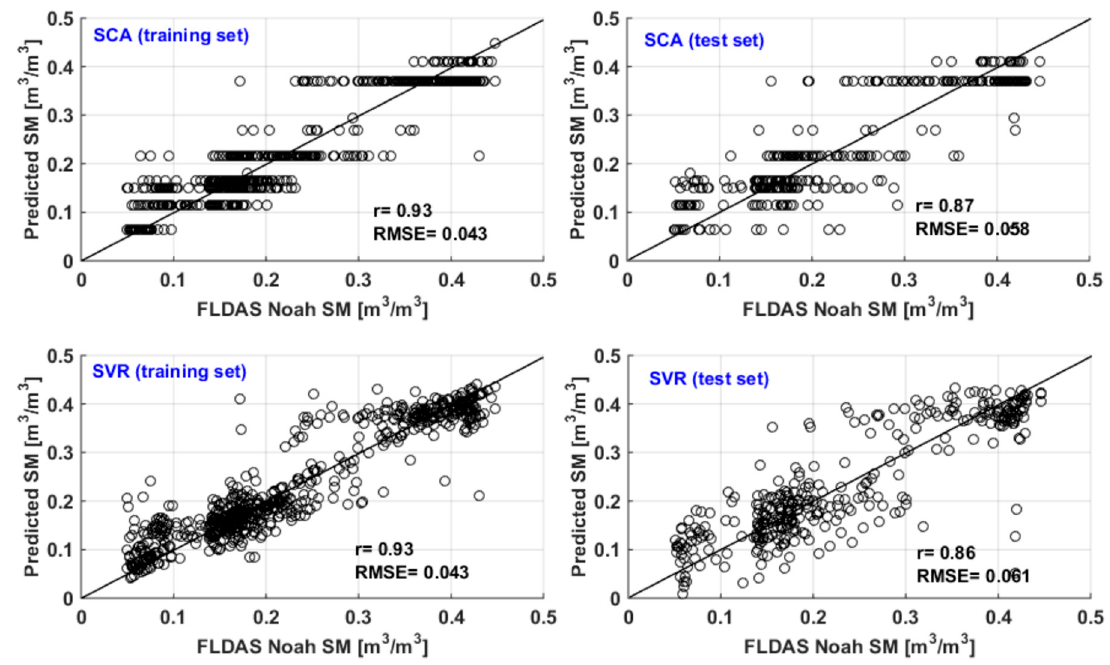
Figure 8. Prediction comparsion of SCA and SVR for FLDAS Noah based cluster tree..